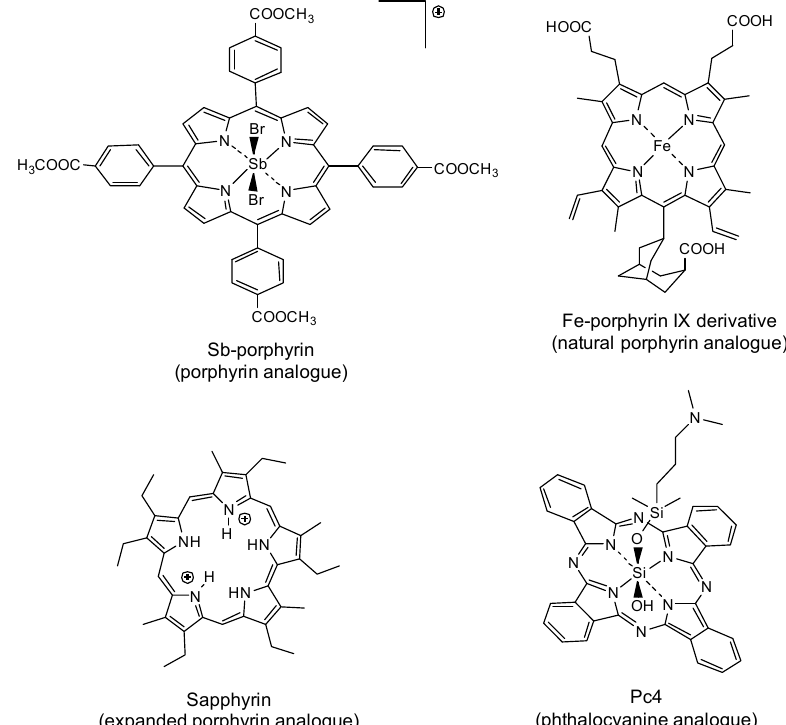
Figure 1. Chemical structures of the most relevant tetrapyrrolic macrocycle candidates as photosensitizers for antiparasitic